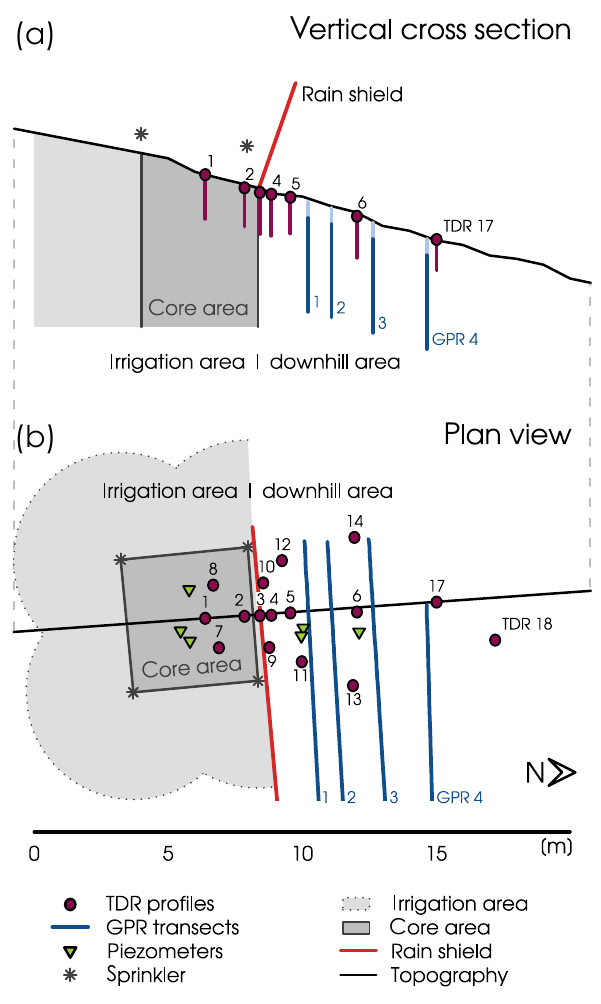
Figure 4. Vertical cross section (a) and plan view (b) of the exper- imental setup and sprinkler array. Location and depth of the TDR profiles and GPR transects are given in purple and blue, respec- tively. The black line along the central TDR transect in (b) marks the vertical cross section depicted in (a)